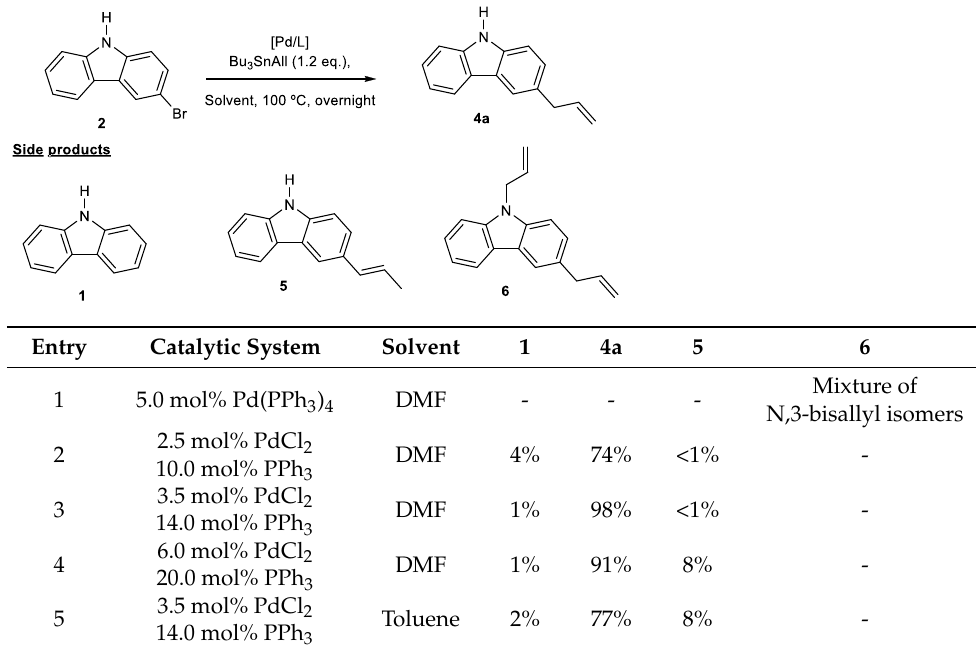
Table 1. Optimization of the Stille coupling of 3-bromocarbazole.